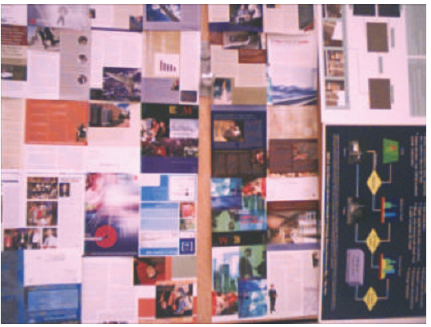
Figure 7: One frame in the “wall” sequence.